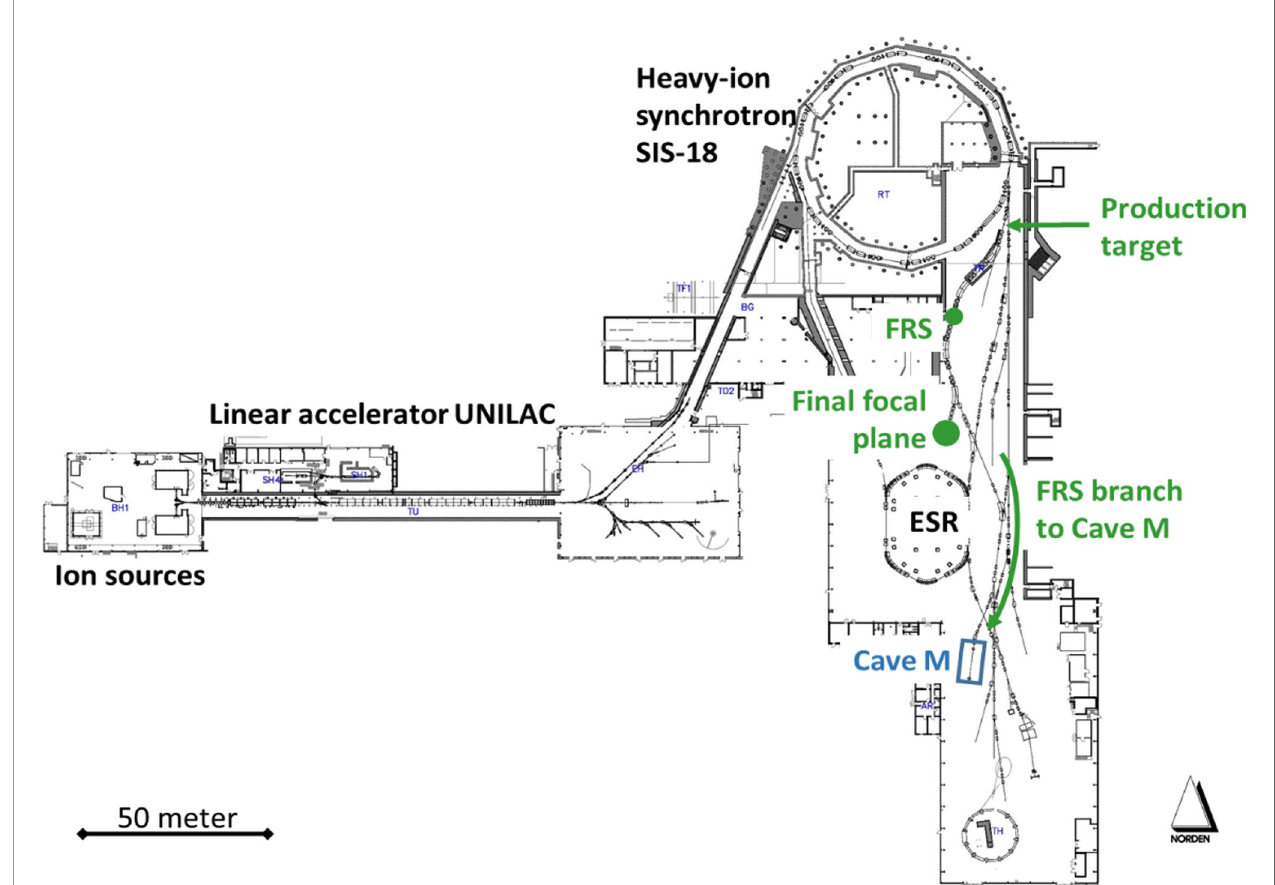
FIGURE 2 | Overview of the existing GSI-FAIR accelerator facility UNILAC-SIS-ESR. The FRS is the radioactive beam facility of GSI and a high-resolution magnetic spectrometer that provides a large variety of secondary nuclear beams ranging from hydrogen up to uranium, among them 10,11 C or 14,15 O, which can be produced from intense primary beams (like 12 C or 16 O) in the production target at its entrance. The ions of interest are identi fi ed in fl ight, spatially separated, energy bunched and used for experimental studies at the FRS itself (central and fi nal focal plane, respectively, indicated by green dots) or they are transmitted via the FRS branch to the target hall for experiments in Cave